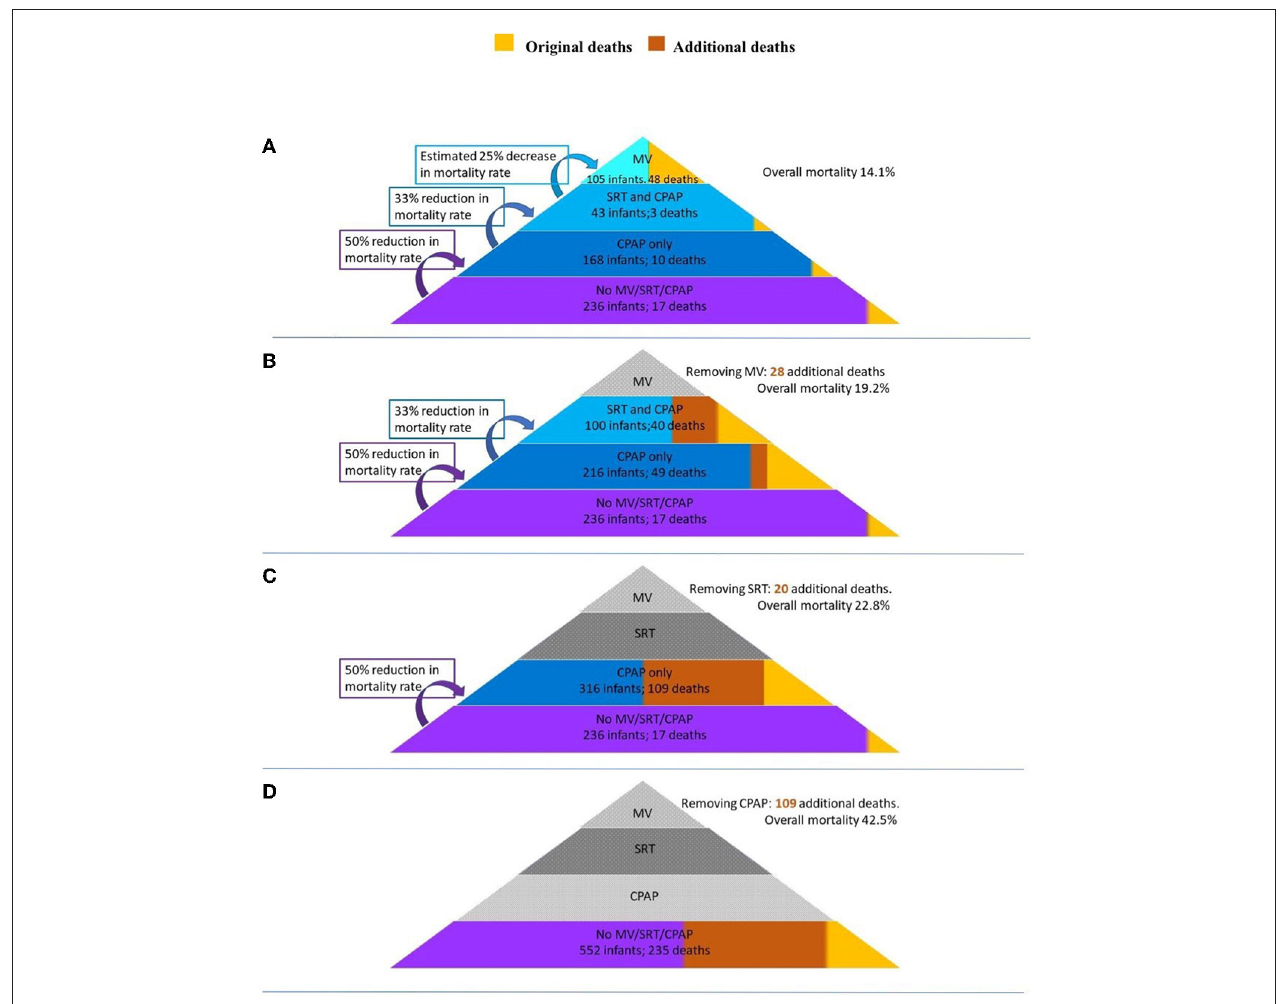
FIGURE 5 | A model of the additional deaths and mortality rates of the study should respiratory interventions be sequentially removed. (A) All interventions available (baseline). (B) MV removed. (C) SRT removed. (D) CPAP removed. MV, invasive mechanical ventilation; SRT, surfactant replacement therapy; CPAP, continuous positive airway